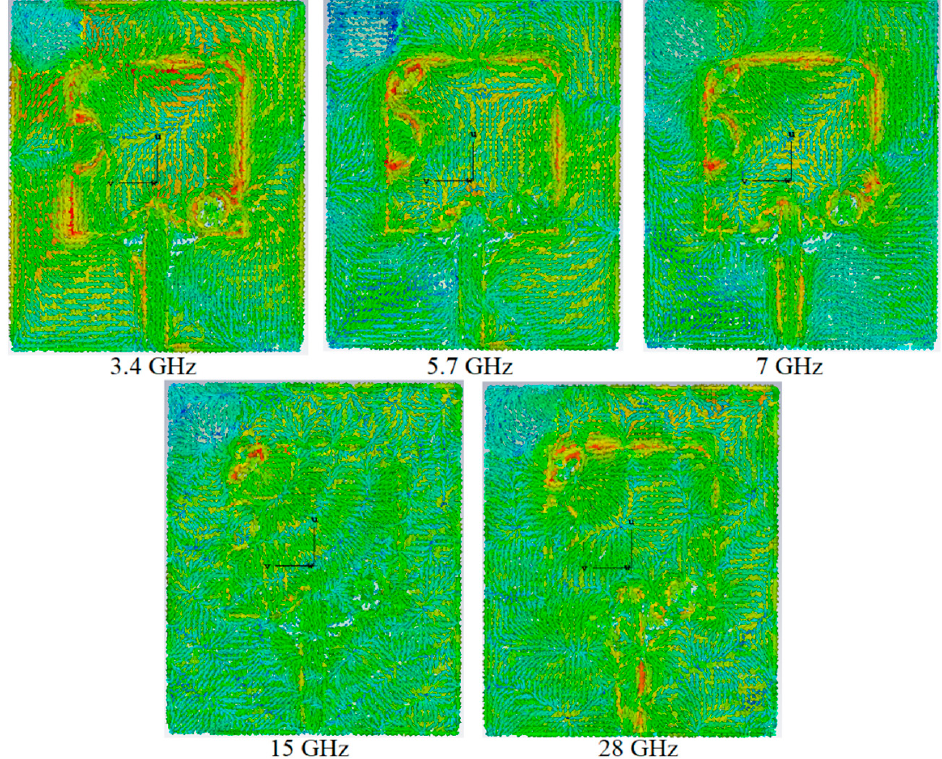
Figure 3. The surface current distribution (SCD) at 5G, sub-6 GHz, lower-end, and higher-end of the working band.